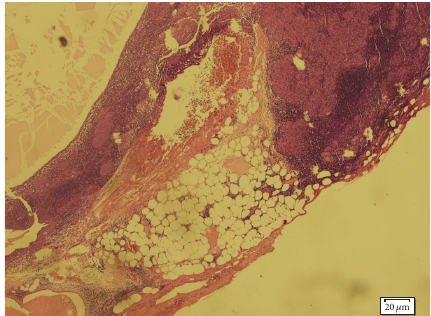
Figure 4: Microscopic view of second patient’s sample. It shows microscopic focus of invasion, microcystic formation, and discrete and confluent epithelial nodules (H&E stain ×